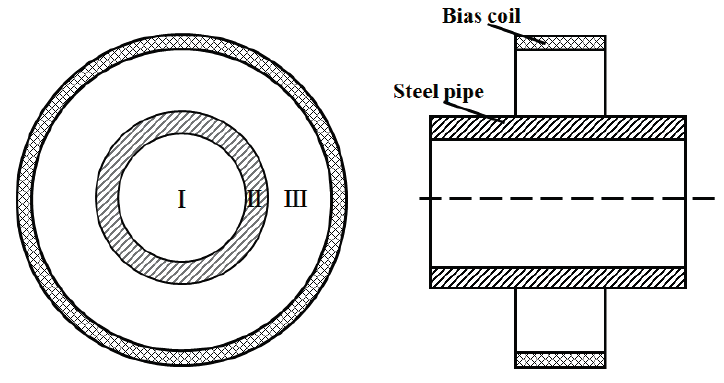
Figure 1. The layout of the receiving position. Zone I: the air zone inside the pipe; Zone II: the wall of the pipe; Zone III: the air zone from the outside surface of the pipe to the bias